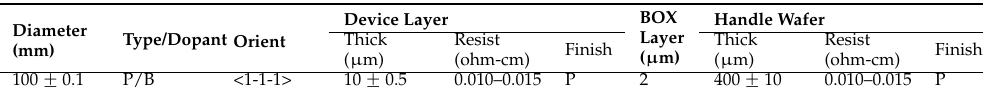
Table 6. Specification of the silicon-on-insulator (SOI)